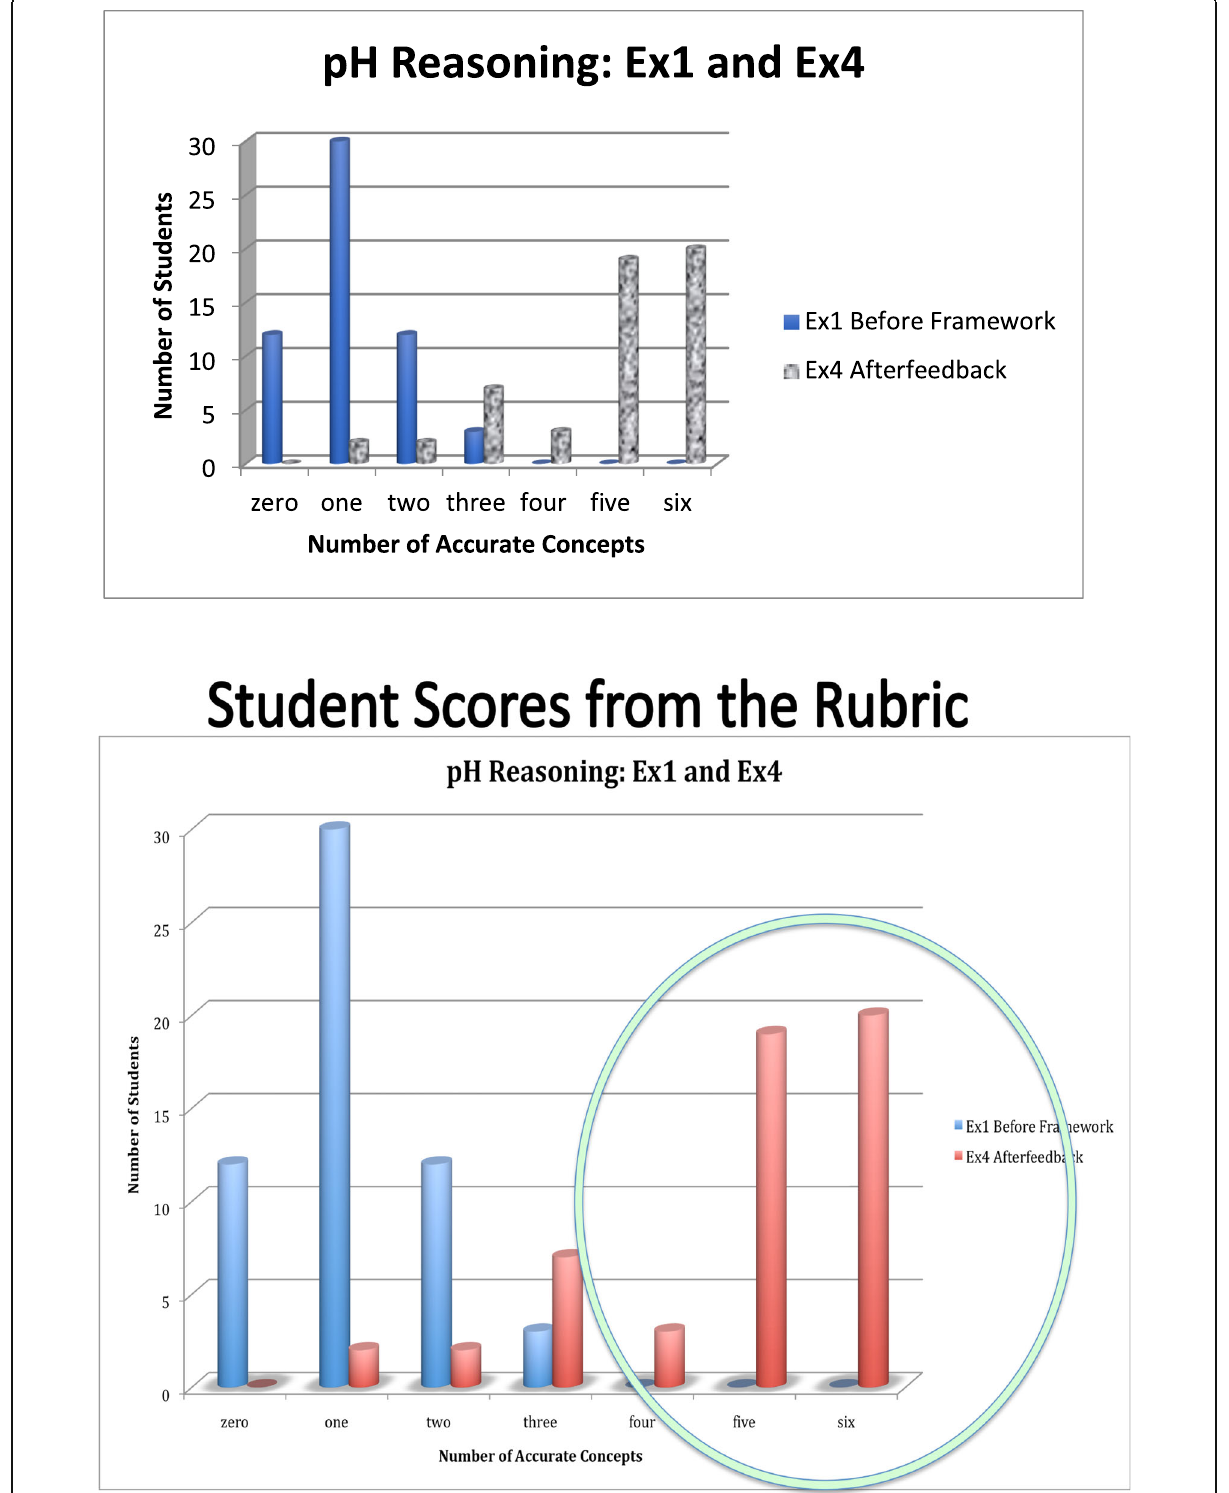
Fig. 6 Student Scores from Rubric: Initial Explanation (Ex1) compared to Final Explanation